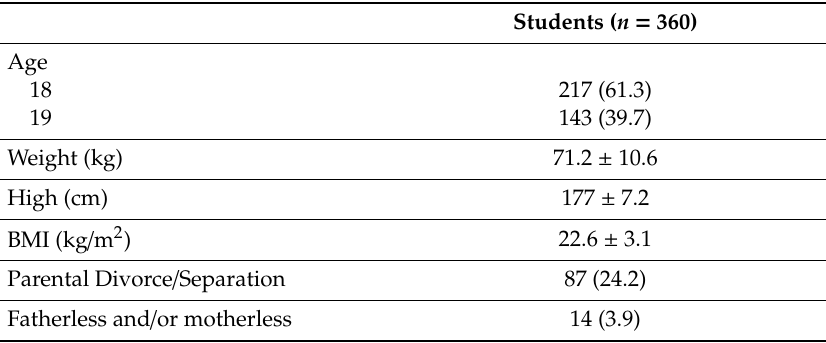
Table 1. Clinical Features of enrolled students.